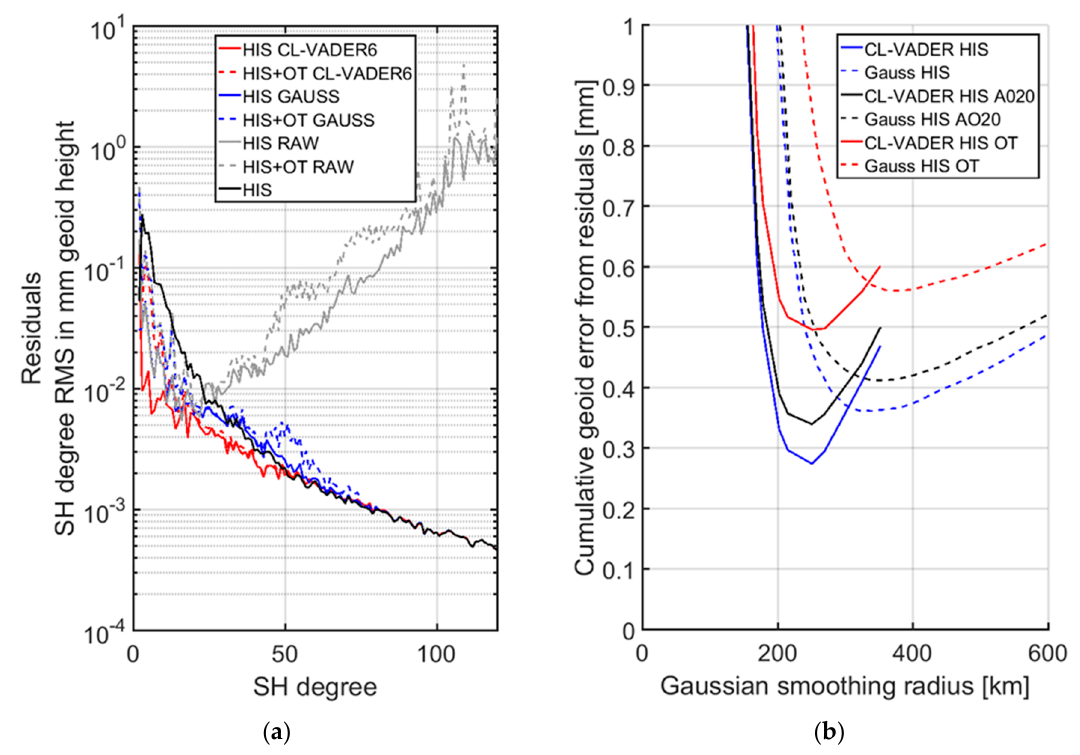
Figure 5. ( a ) SH degree RMS in mm geoid height of the residuals of the raw (gray) and the filtered solutions using the VADER (red) and the Gaussian filter (blue) in comparison with the mean HIS signal (black) for month 2009-08. Ocean tide errors are added in terms of ocean tide model difference signal (dashed lines). ( b ) Cumulative geoid errors in mm for different filter radii (for the VADER filter the average radii are given) computed from the residuals of all monthly solutions (median is shown) with respect to the corresponding HIS signal filtered with VADER (solid lines) and Gaussian (dashed lines). Complete de-aliasing (blue) is compared with effects of ocean tide model differences (red) and of 20% of the non-tidal atmospheric and oceanic signals (black).